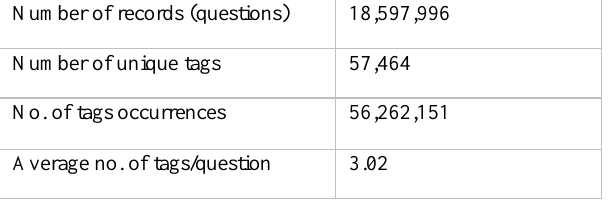
Table 1. Statistical of raw data, time between (2008 and 2019).